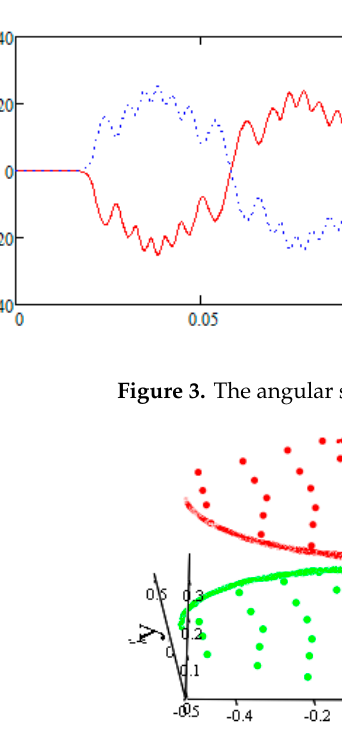
Figure 4. The trajectories of individual atoms belonging to di ff erent disks.